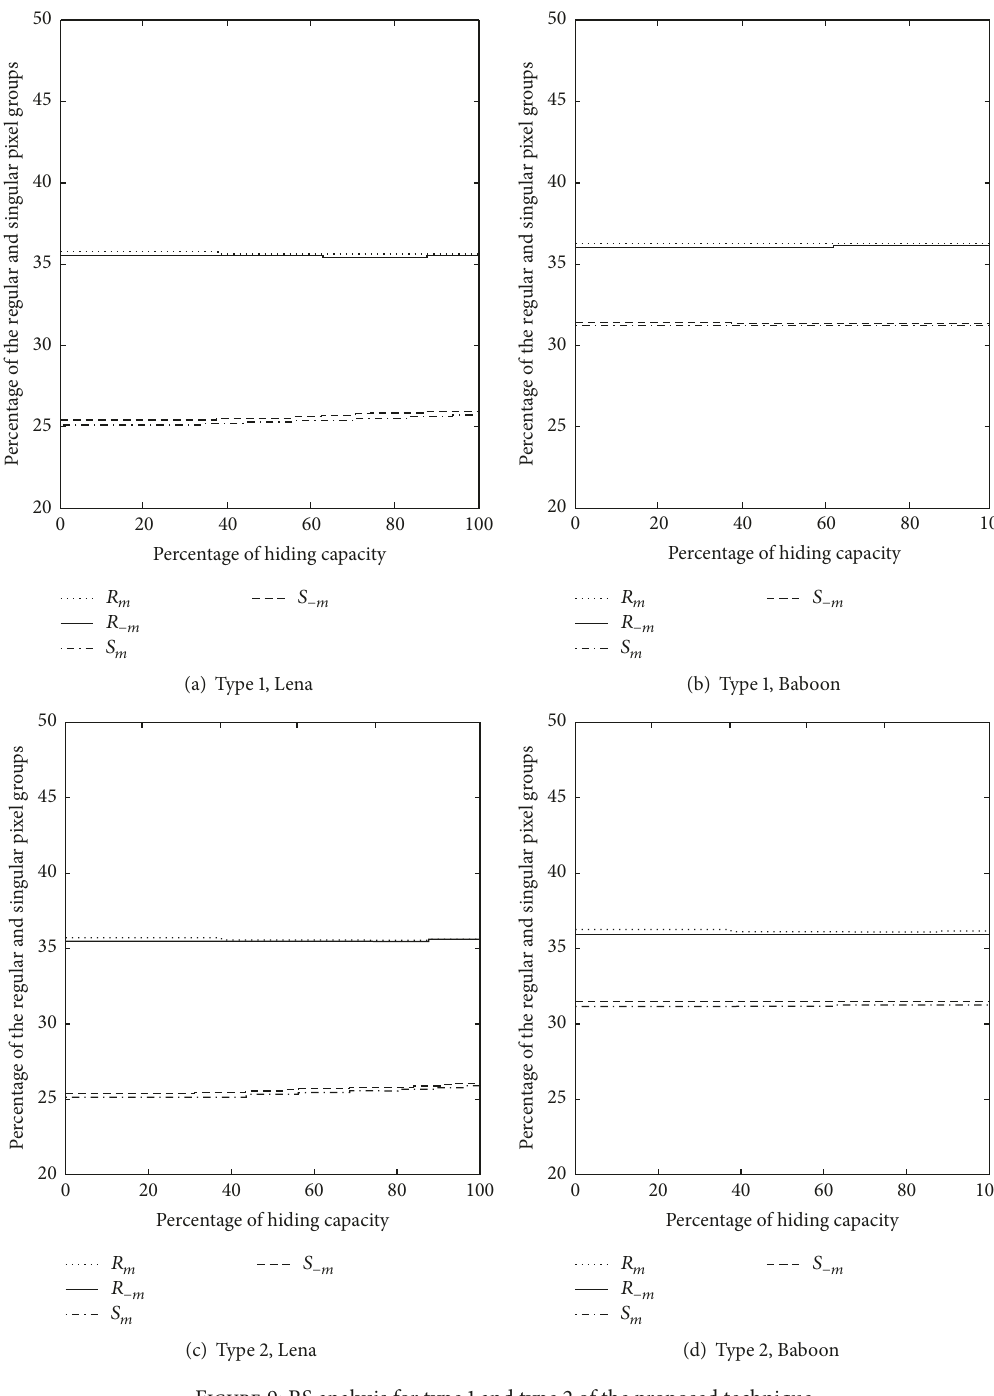
Figure 9: RS analysis for type 1 and type 2 of the proposed